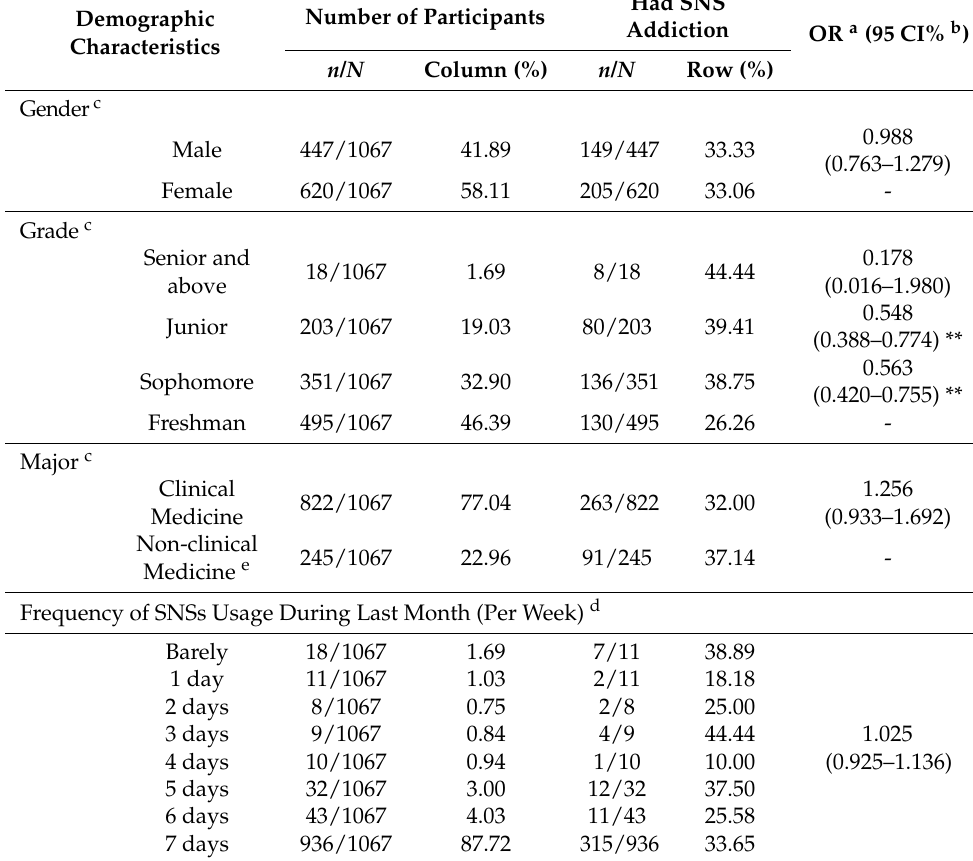
Table 1. Demographic characteristics of participants ( n ,